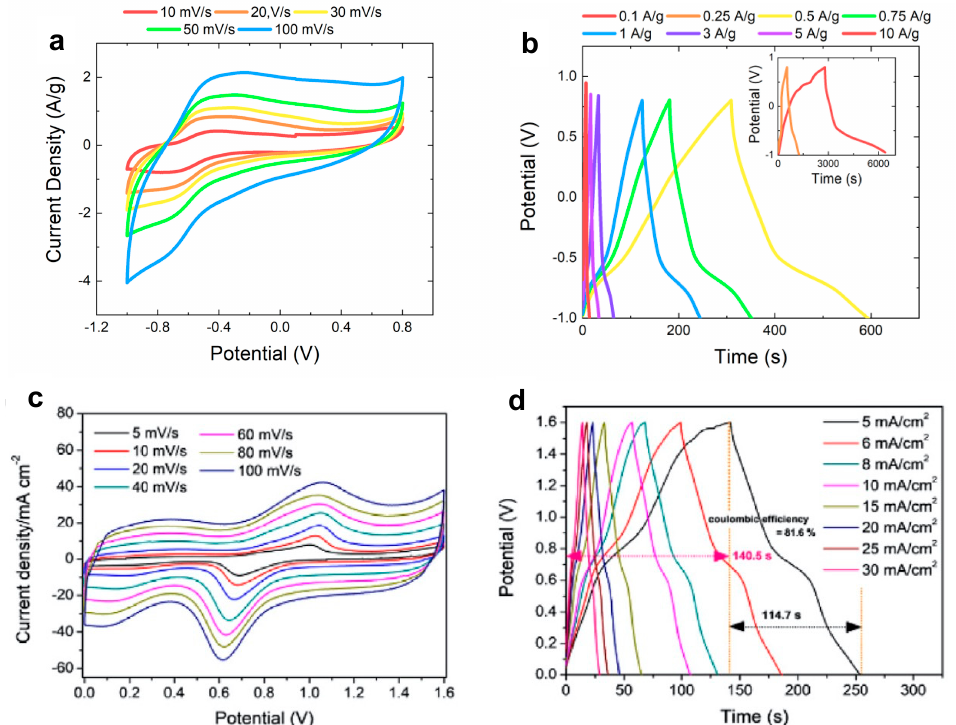
Figure 9. ( a ) CV curves of an ASC by using WO 3 nanorods as anode and graphene paper as cathode and ( b ) related GCD curves [19]; ( c ) CV curves of an ASC by using WO 3 nanorods as anode and RuO 2 as cathode and ( d ) related GCD curves at different current densities [46]. Reproduced with permission. Table 4. State-of-the-art on energy storage applications of WO 3 -based ASCs and SSCs.